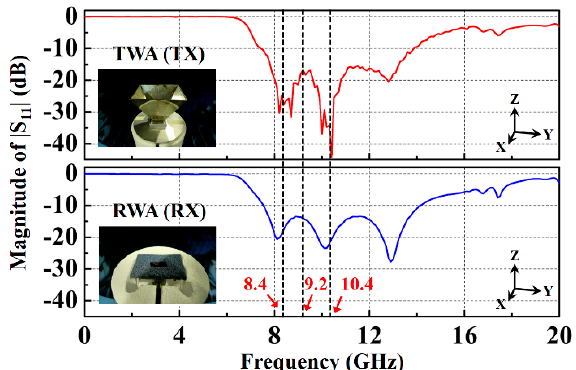
Figure 3. Measured magnitude |S 11 | of the transmitting waveguide antenna and the receiving waveguide antenna.